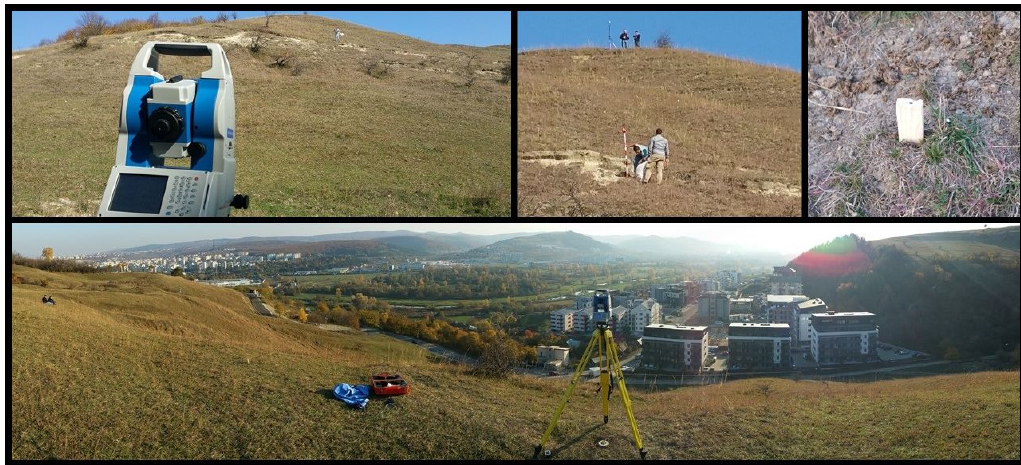
Figure 8. Land survey stages.